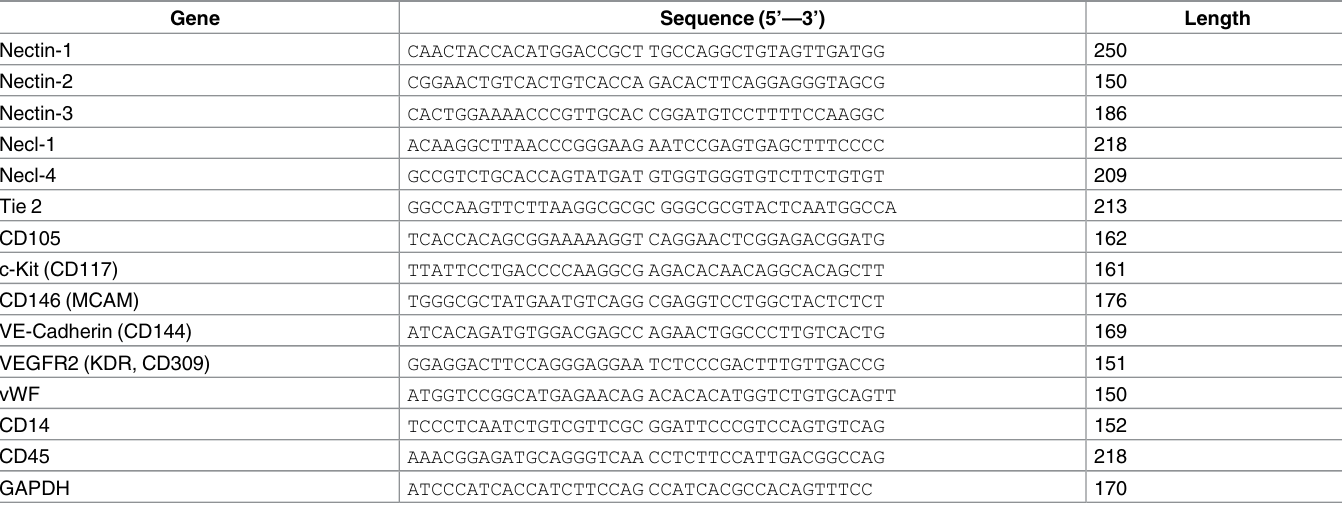
Table 1. Quantitative real-time PCR primers.